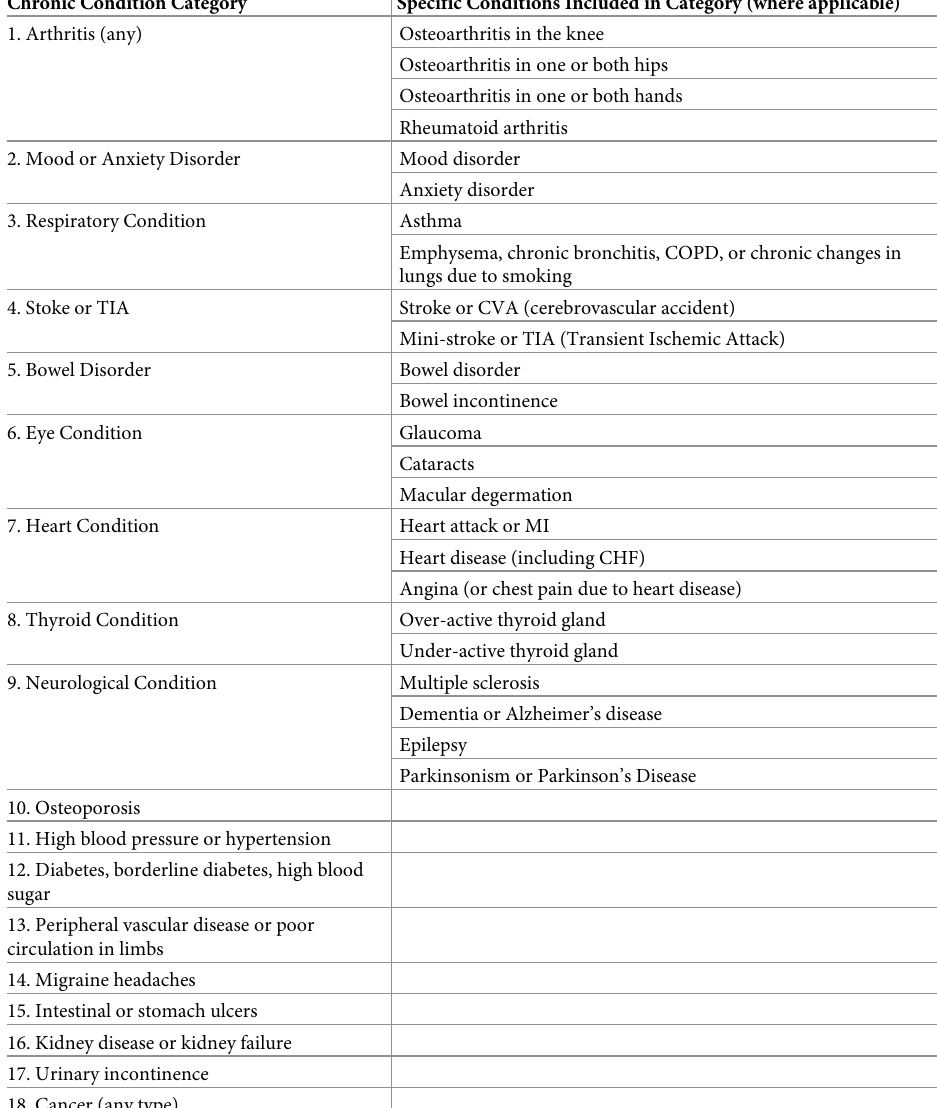
Table 1. Summary of chronic conditions grouping for self-reported conditions in the Canadian Longitudinal Study on Aging. Chronic Condition